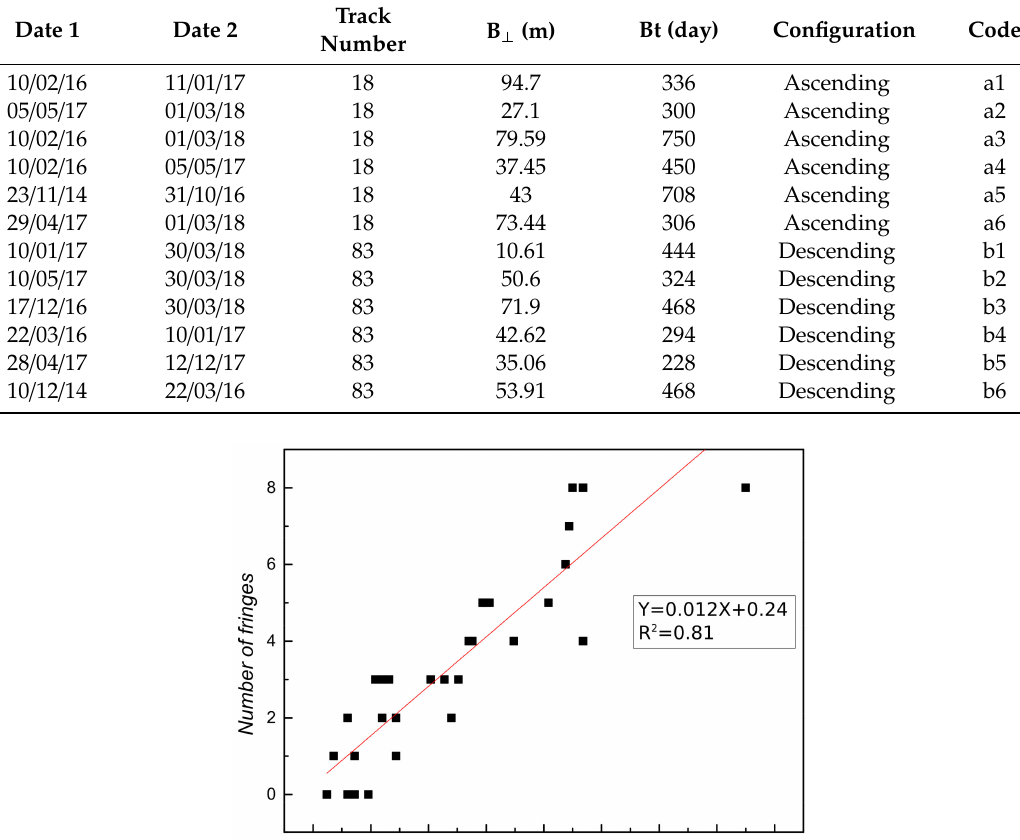
Table 1. Details of the Sentinel-1 datasets used in the stacking process corresponding to Single Look Complex (SLC) product types with Interferometric Wide (IW) beam mode. B ⊥ refers to the perpendicular baseline. Bt refers to the time baseline between data sets. The code refers to the interferograms results presented in Section 4.2.